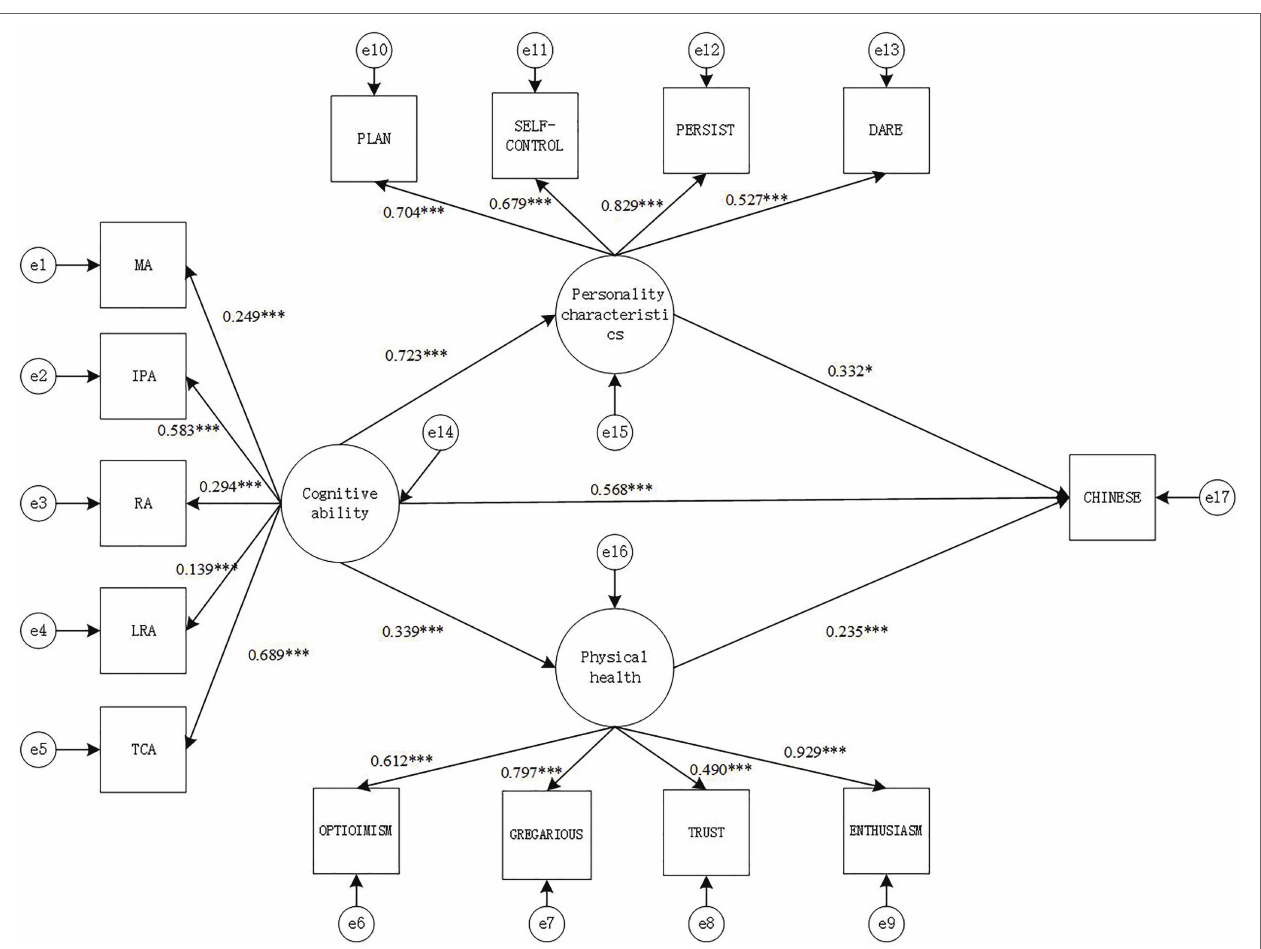
FIGURE 2 | Structural equation intermediary relationship model diagram (model 2). MA, memory ability; IPA, information processing ability; RA, representation ability; LRA, logical reasoning ability; TCA, thinking conversion ability; TS, academic performance. * p < 0.05, and *** p < 0.001.